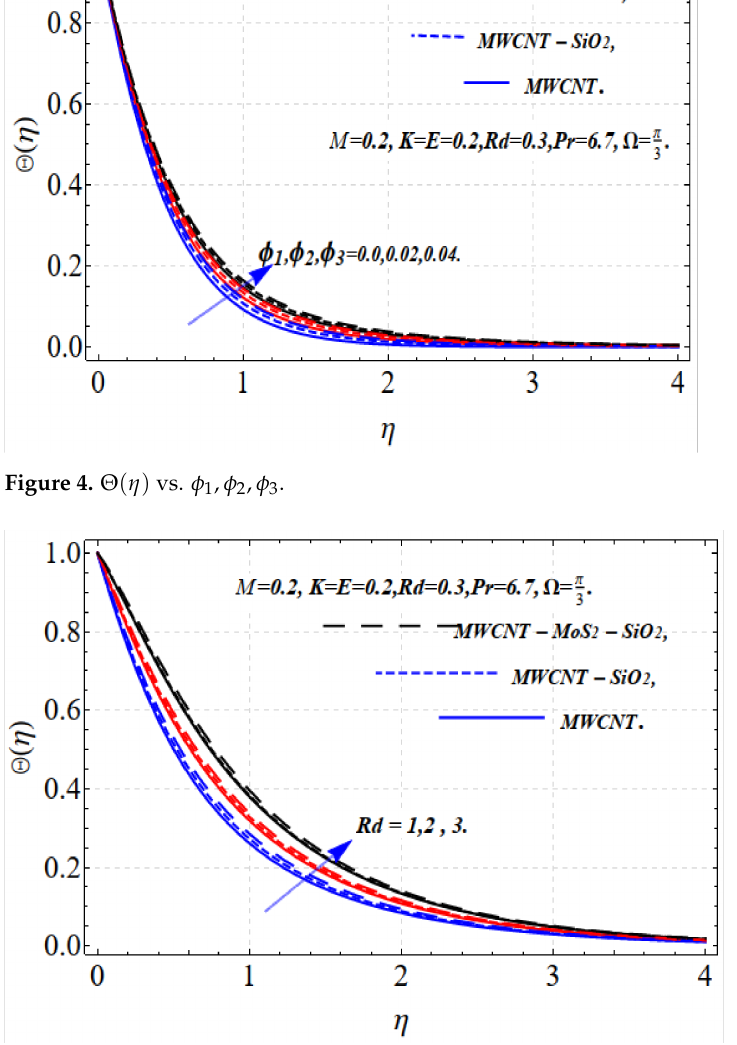
Figure 5. Θ ( η ) vs. Rd . Table 1. Heat transfer calculated as a percentage for each